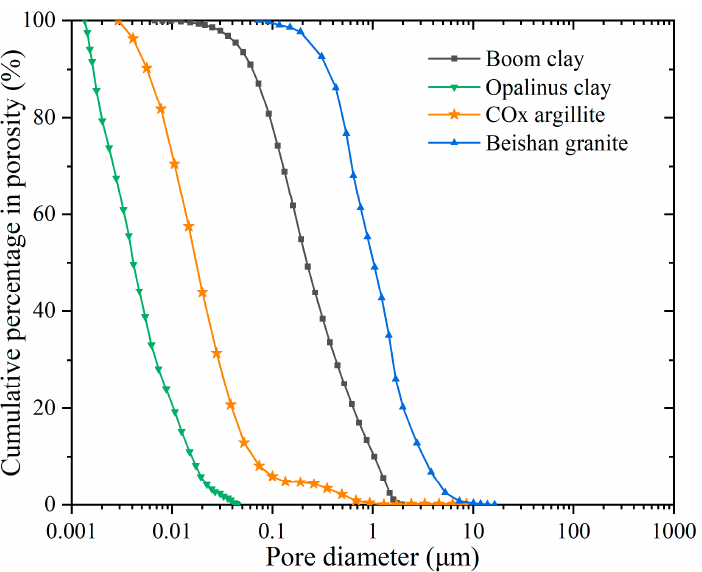
Figure 2. Sample and instrument. ( a ) Beishan granite sample; ( b ) NMR instrument.